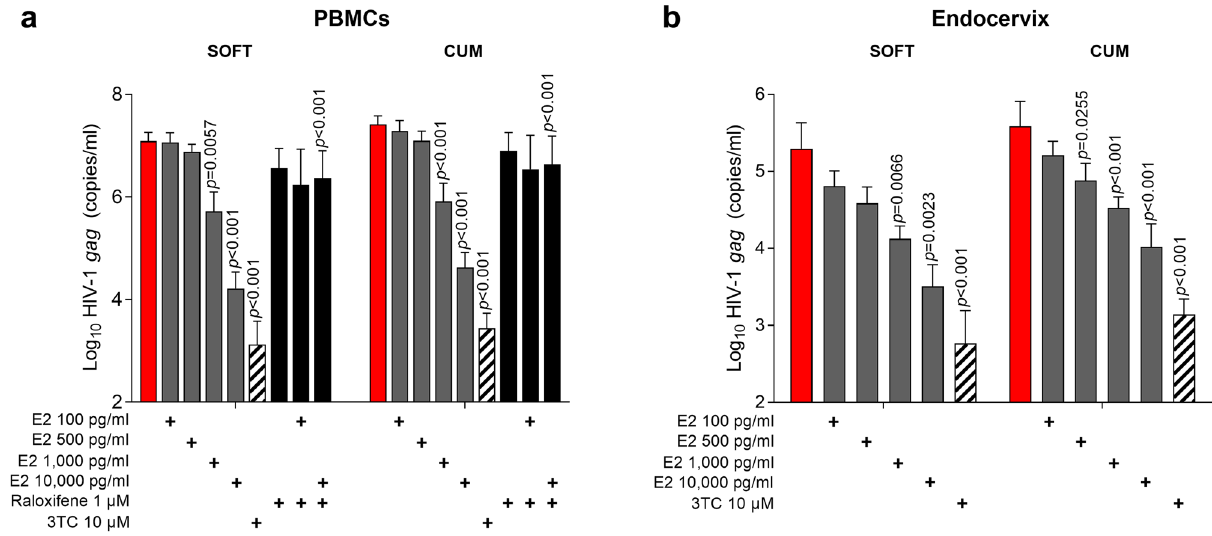
Figure 1. E2 inhibits HIV-1 BaL infection in PBMCs and endocervix in vitro. (a) PBMCs and (b) endocervical explants were incubated with E2 (vs. untreated control) for 48 h followed by 1000 TCID 50 /10 6 cells or